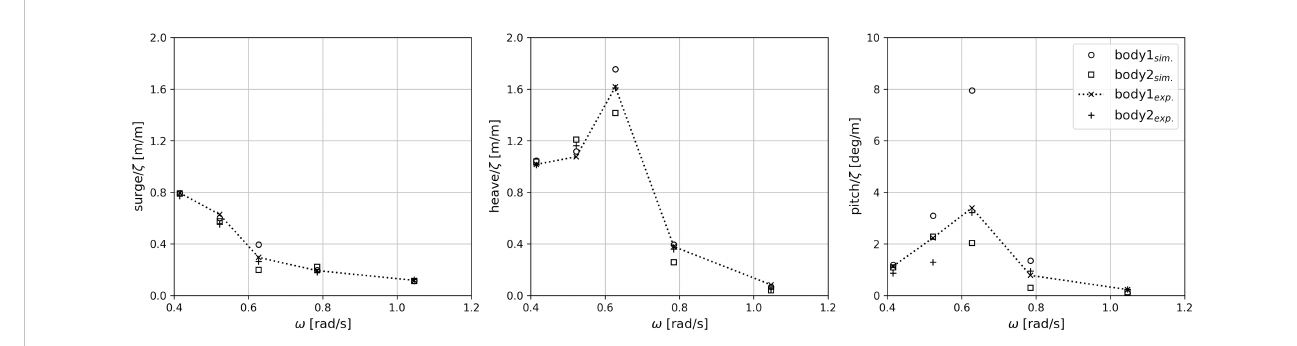
FIGURE 6 Computed and measured motion responses of a hinged two-module platform in head